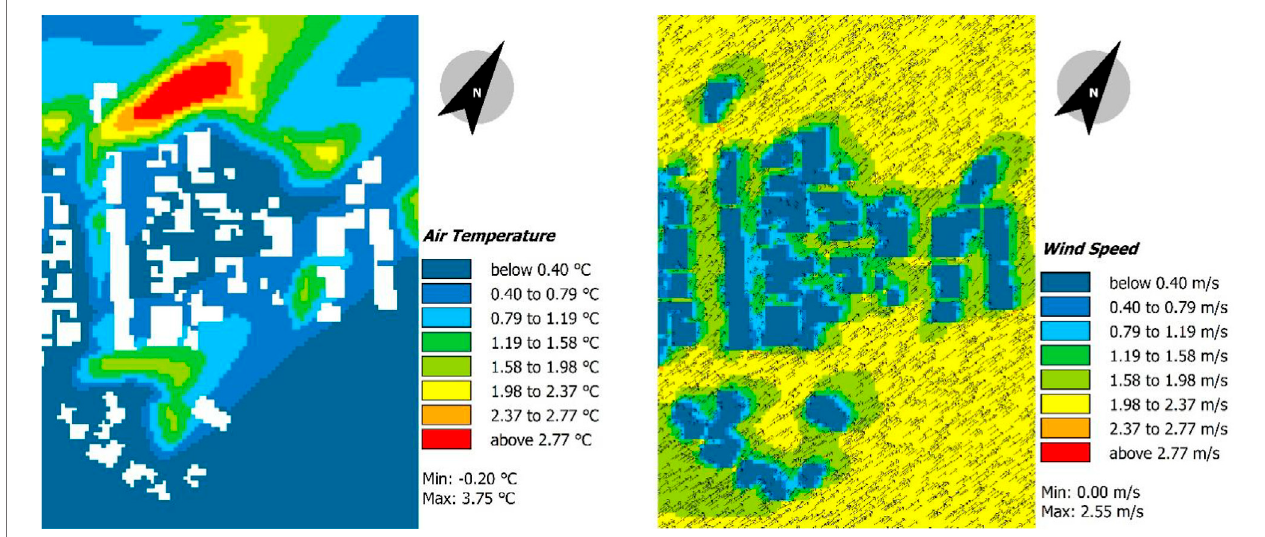
FIGURE 9 | Air temperature (left) and wind speed (right) within the case study area at 14:00 on July 15.